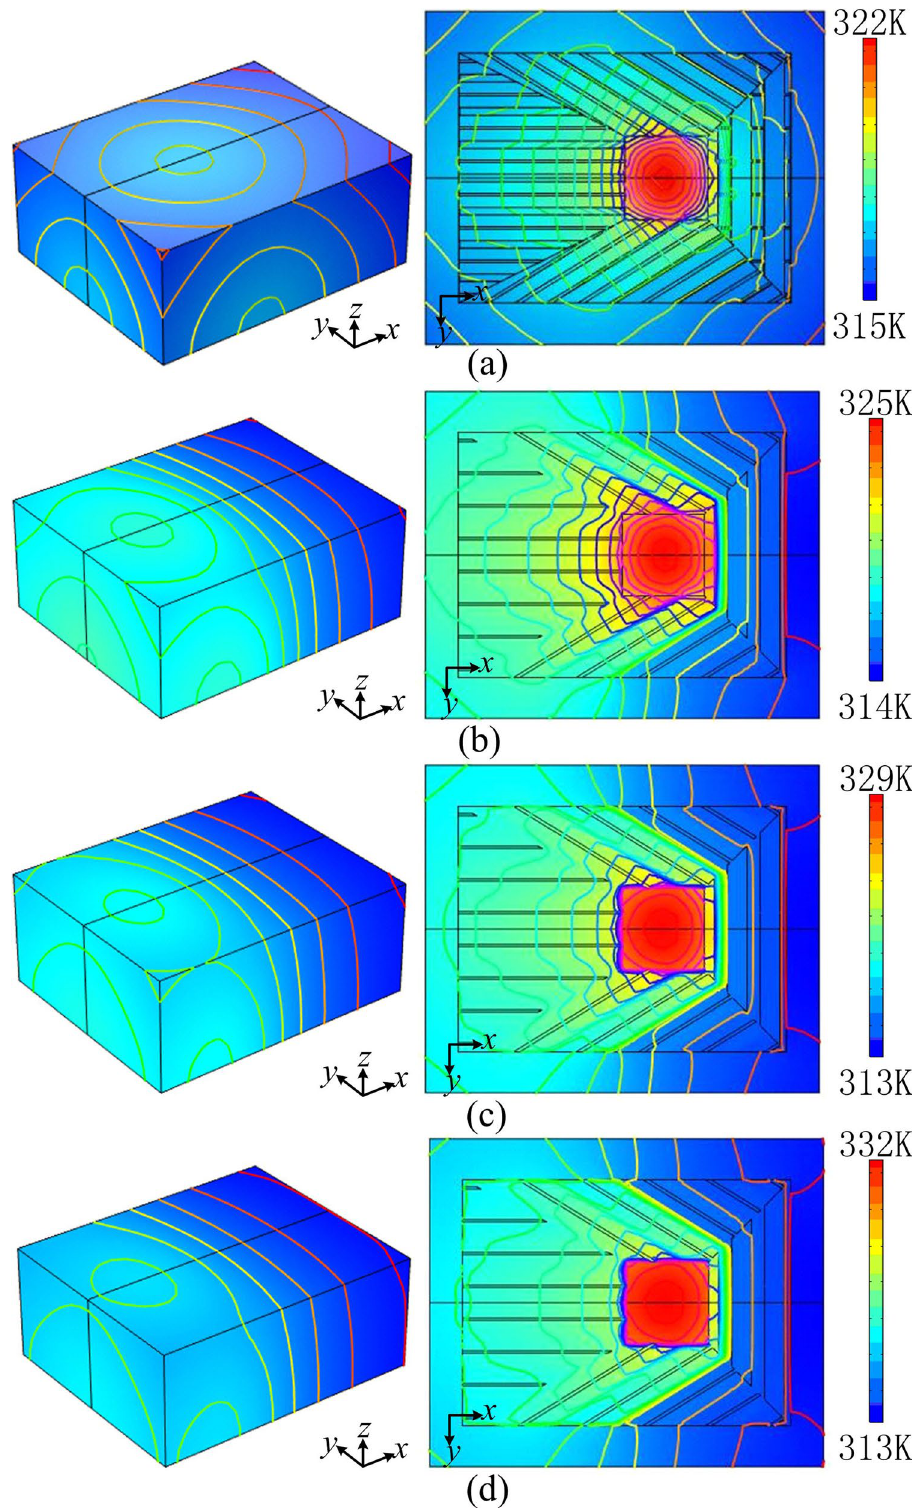
Figure 5. The simulated temperature profiles produced by heat sources for different thermal devices: ( a ) device with designed structures; ( b ) device with simplified structures; ( c ) device with simplified structures (with ITR 0.0005 K ⋅ m 2 /W); and ( d ) device with simplified structures (with ITR 0.001 K ⋅ m 2